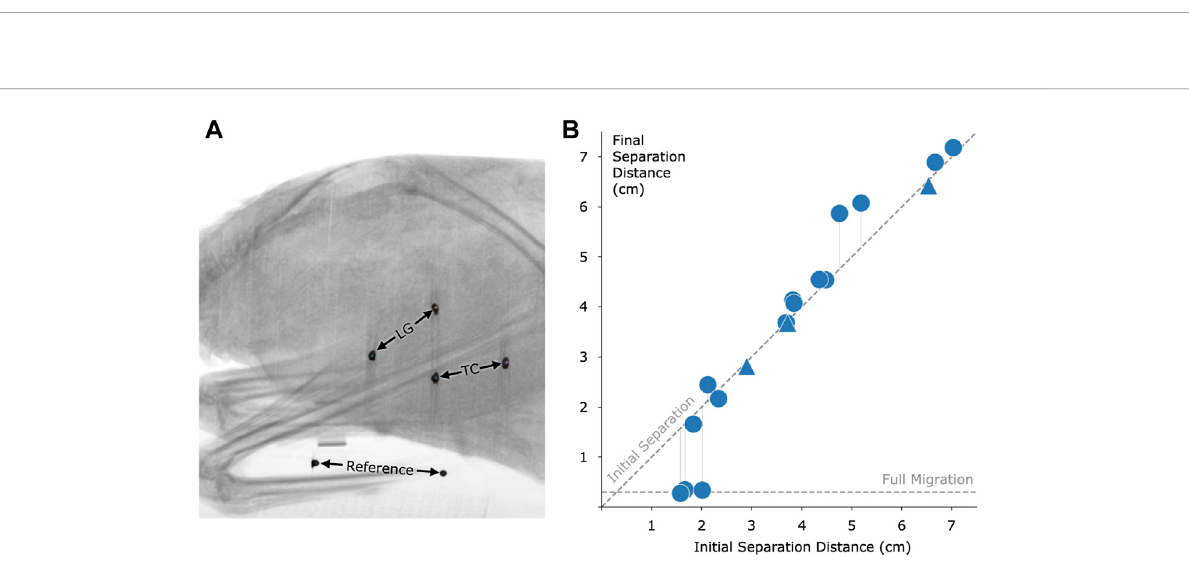
FIGURE 6 Magnetic bead pair stability against migration in muscle. (A) Computed tomography image of one of the turkeys with the implanted magnetic beads. In this case, magnets were implanted in the lateral gastrocnemius (LG) and tibialis cranialis (TC) muscles. A consistent reference, seen at the bottomofthe fi gure,wasincludedinallscanstoensurerepeatabledistancemeasurements. (B) Effectofinitialimplantseparationonmigrationofthe magnetic beads, seen by comparing thevertical position of each data point to the diagonal dashed line. The horizontal dashed line, labeled Full Migration, indicates the distance between bead centers when they are touching (3 mm center to center). The fi nal magnetic bead pair separation is the separation at 8 months post-implantation. We observed a lack of full migration for all implant pairs at or above an initial separation distance of 2.12 cm. Triangles indicate pairwise distances between three magnets that were placed approximately in line within a single muscle. Refer to Supplementary Table S1 for this data in a numerical